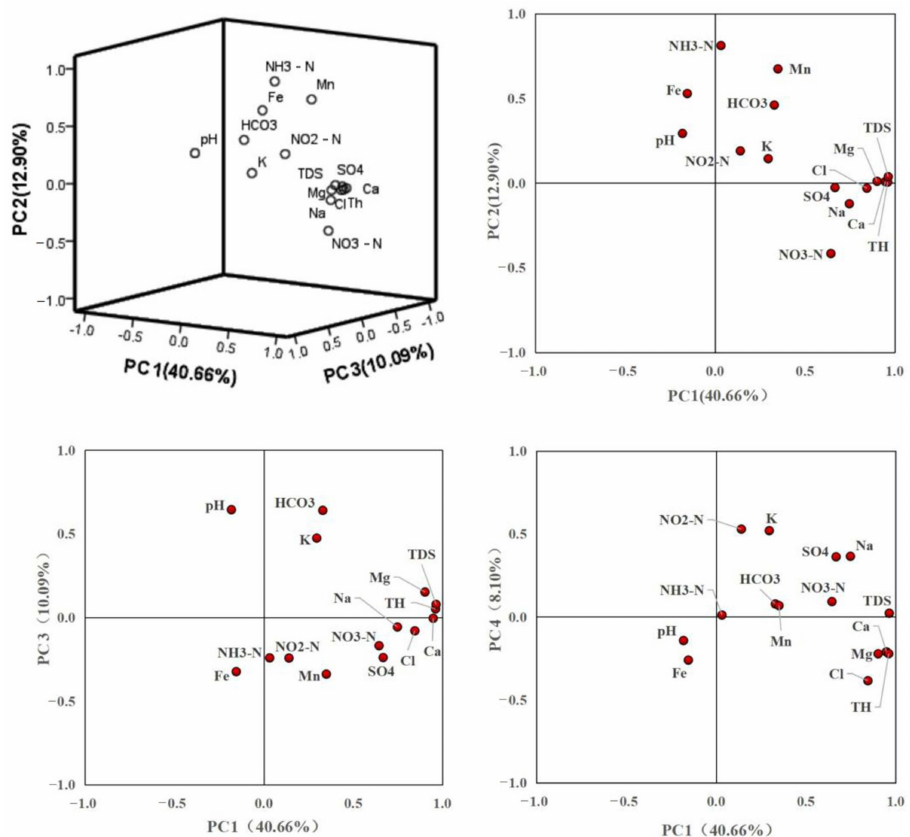
Figure 7. Principal components load